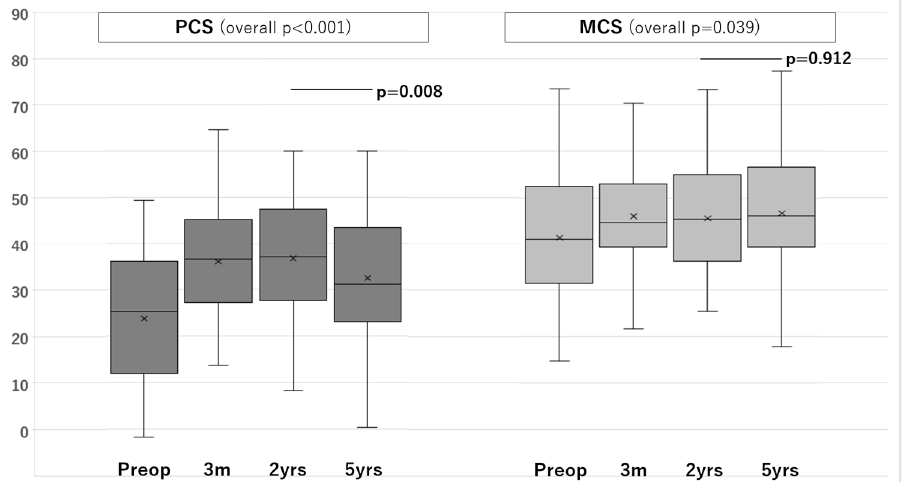
Figure 1. Changes in the average MCS and PCS scores after surgery.